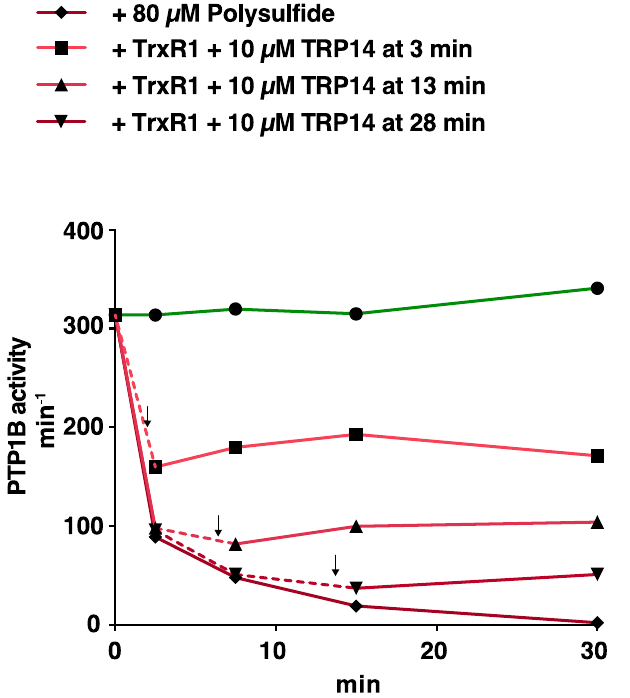
Figure 5. Abrogation of polysulfide-dependent inactivation of PTP1B by addition of the TRP14 redox system. PTP1B (600 nM) was incubated together with 80 µ M polysulfide and aliquots were taken for activity measurements at 5, 15, and 30 min. Two minutes before each time point, addition of TRP14 (10 µ M), NADPH (2 mM), and the TrxR1 (2 µ M) was also performed with specific samples, as indicated with arrows and dashed parts of the curves. Data points represent means ± SEM ( n = 3).